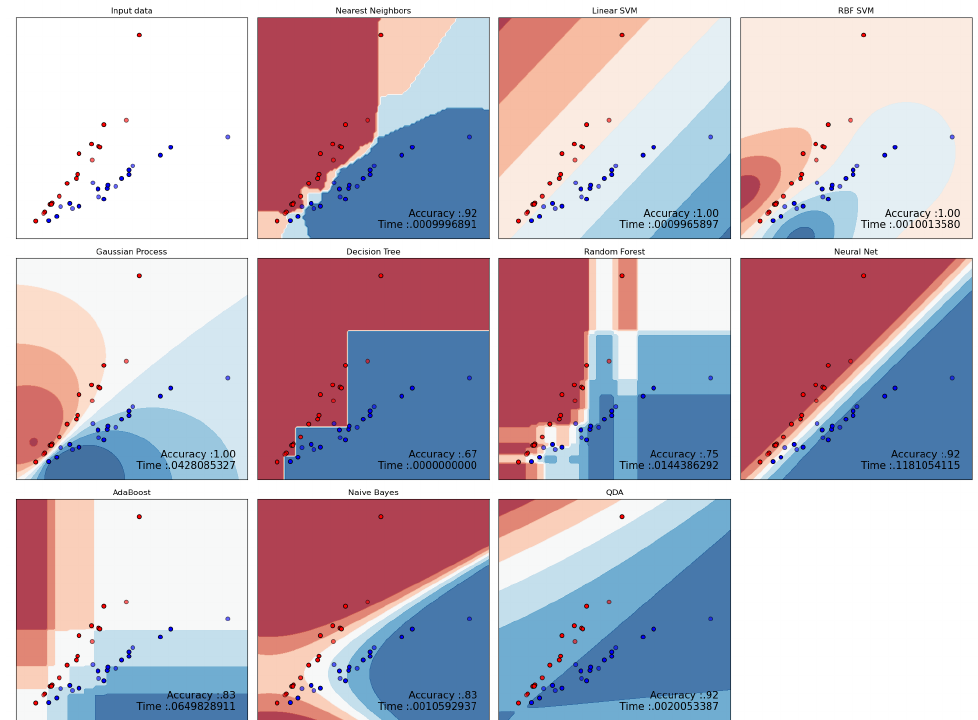
Figure 4. Real Data of volume and weight values visualization of the two classes (Coal in blue and gangue in Red), trained and tested with “Nearest Neighbors”, “Linear SVM”, “RBF SVM", “Gaussian Process”, “Decision Tree”, “Random Forest”, “Neural Net”, “AdaBoost”, “Naive Bayes”, and “QDA” with the decision boundaries display, classification accuracy in a scale of (0–1) and time in